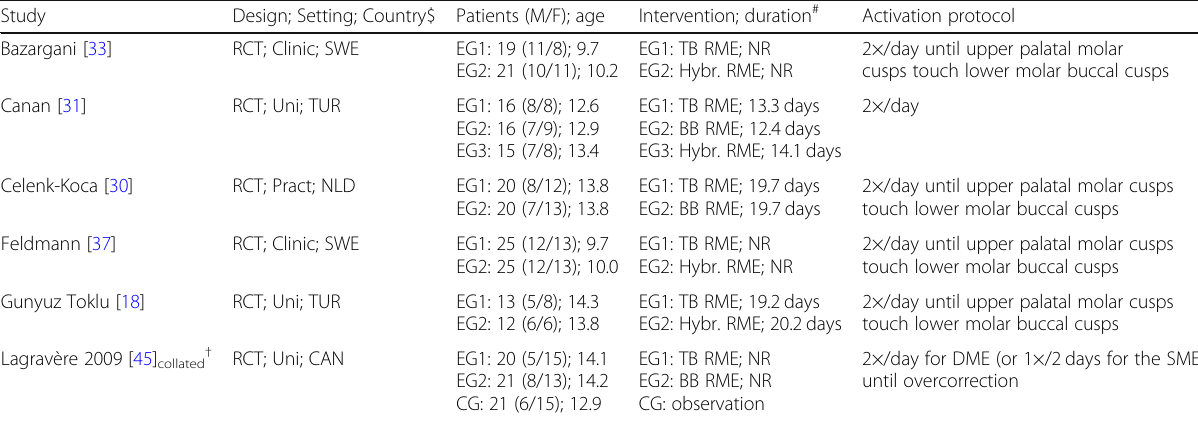
Table 1 Characteristics of included randomized trials pertaining to setting, patients, and intervention Study Design; Setting; Country$ Patients (M/F); age Intervention; duration # Activation